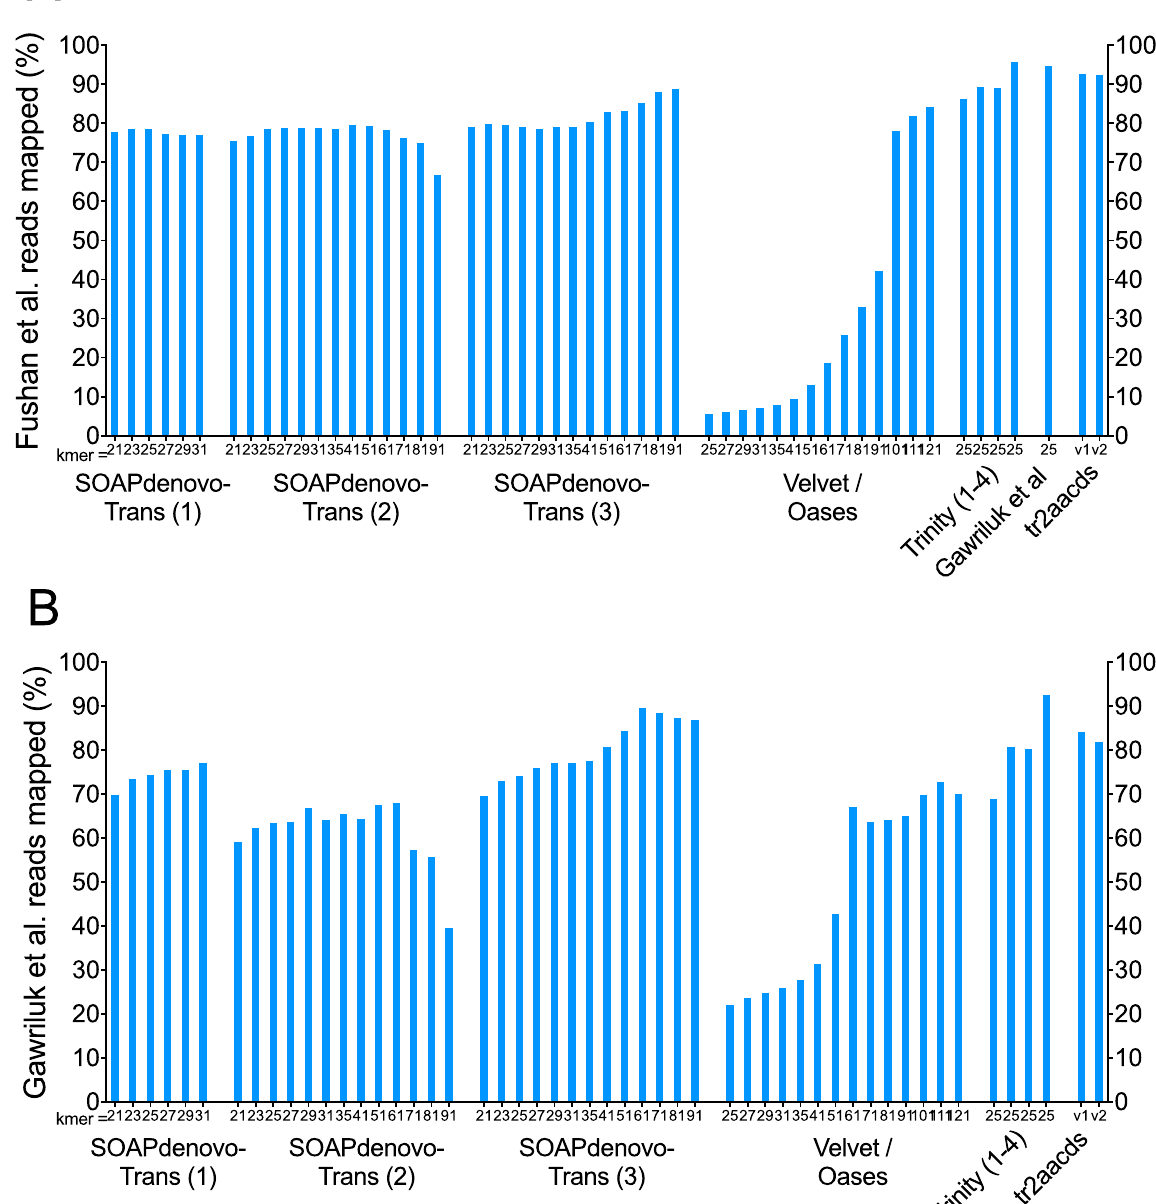
Figure 5. Proportion of independent reads mapping to each transcriptome assembly for ( A ) PRJNA184055 (Fushan et al ., 2015), and ( B ) PRJNA300275 (Gawriluk et al ., 2016). SOAPdenovo-Trans (1): no filtering; (2): light filtering of poor quality read pairs, combined with in silico normalization; (3): moderate filtering of poor quality read pairs; Velvet/Oases: moderate filtering of poor quality read pairs; Trinity (1): light filtering of poor quality read pairs, combined with in silico normalization; (2): light filtering of poor quality read pairs, combined with SEECER error correction; (3): moderate filtering of poor quality read pairs; (4): moderate filtering of poor quality reads and SEECER error correction; (5): Gawriluk et al . transcriptome assembly; tr2aacds merged assemblies (1): pre-v2.3.2 Trinity; (2): including v2.3.2